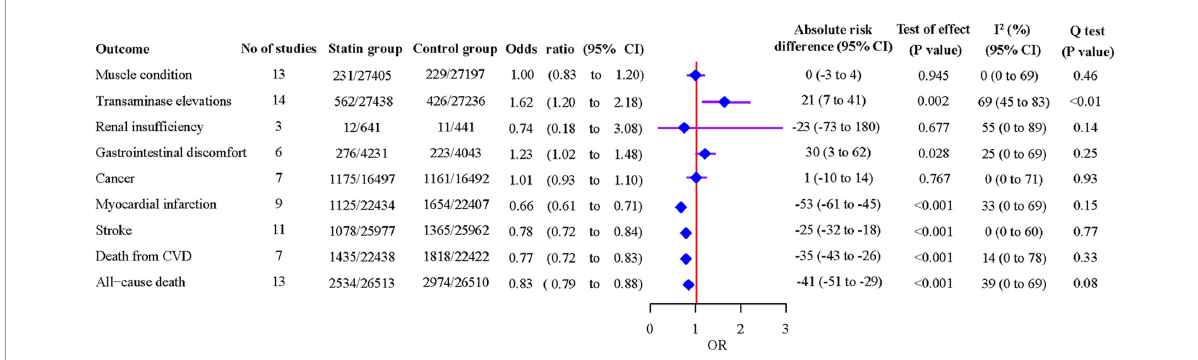
FIGURE3 Associations of statins with safety and efficacy outcomes from pairwise meta-analyses.